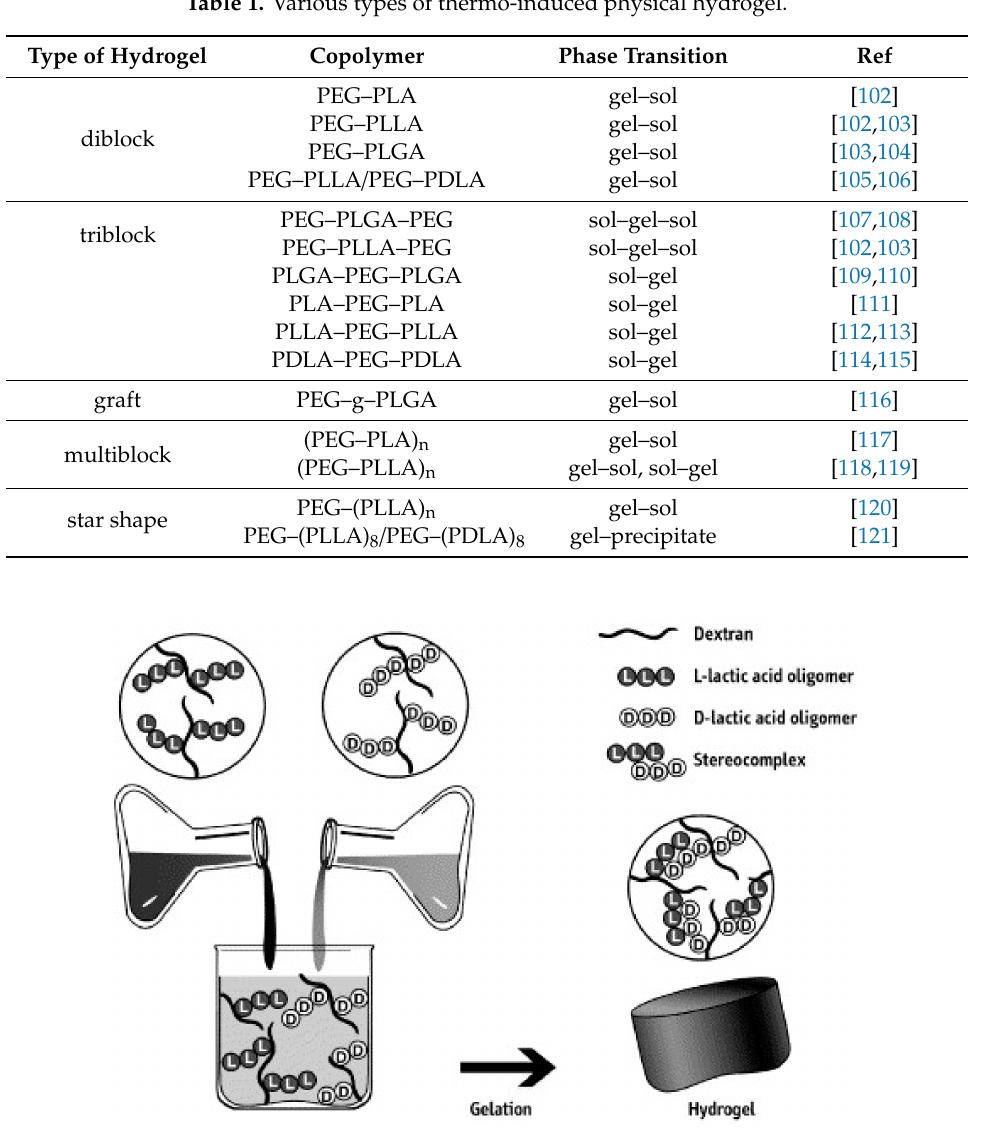
Figure 5. Schematic illustration of the concept of stereocomplex hydrogel formed by mixing aqueous solutions of bio-polymers containing enantiomeric oligo(lactic acid) [125]. Reprinted from Nostrum with permission from Express Polymer